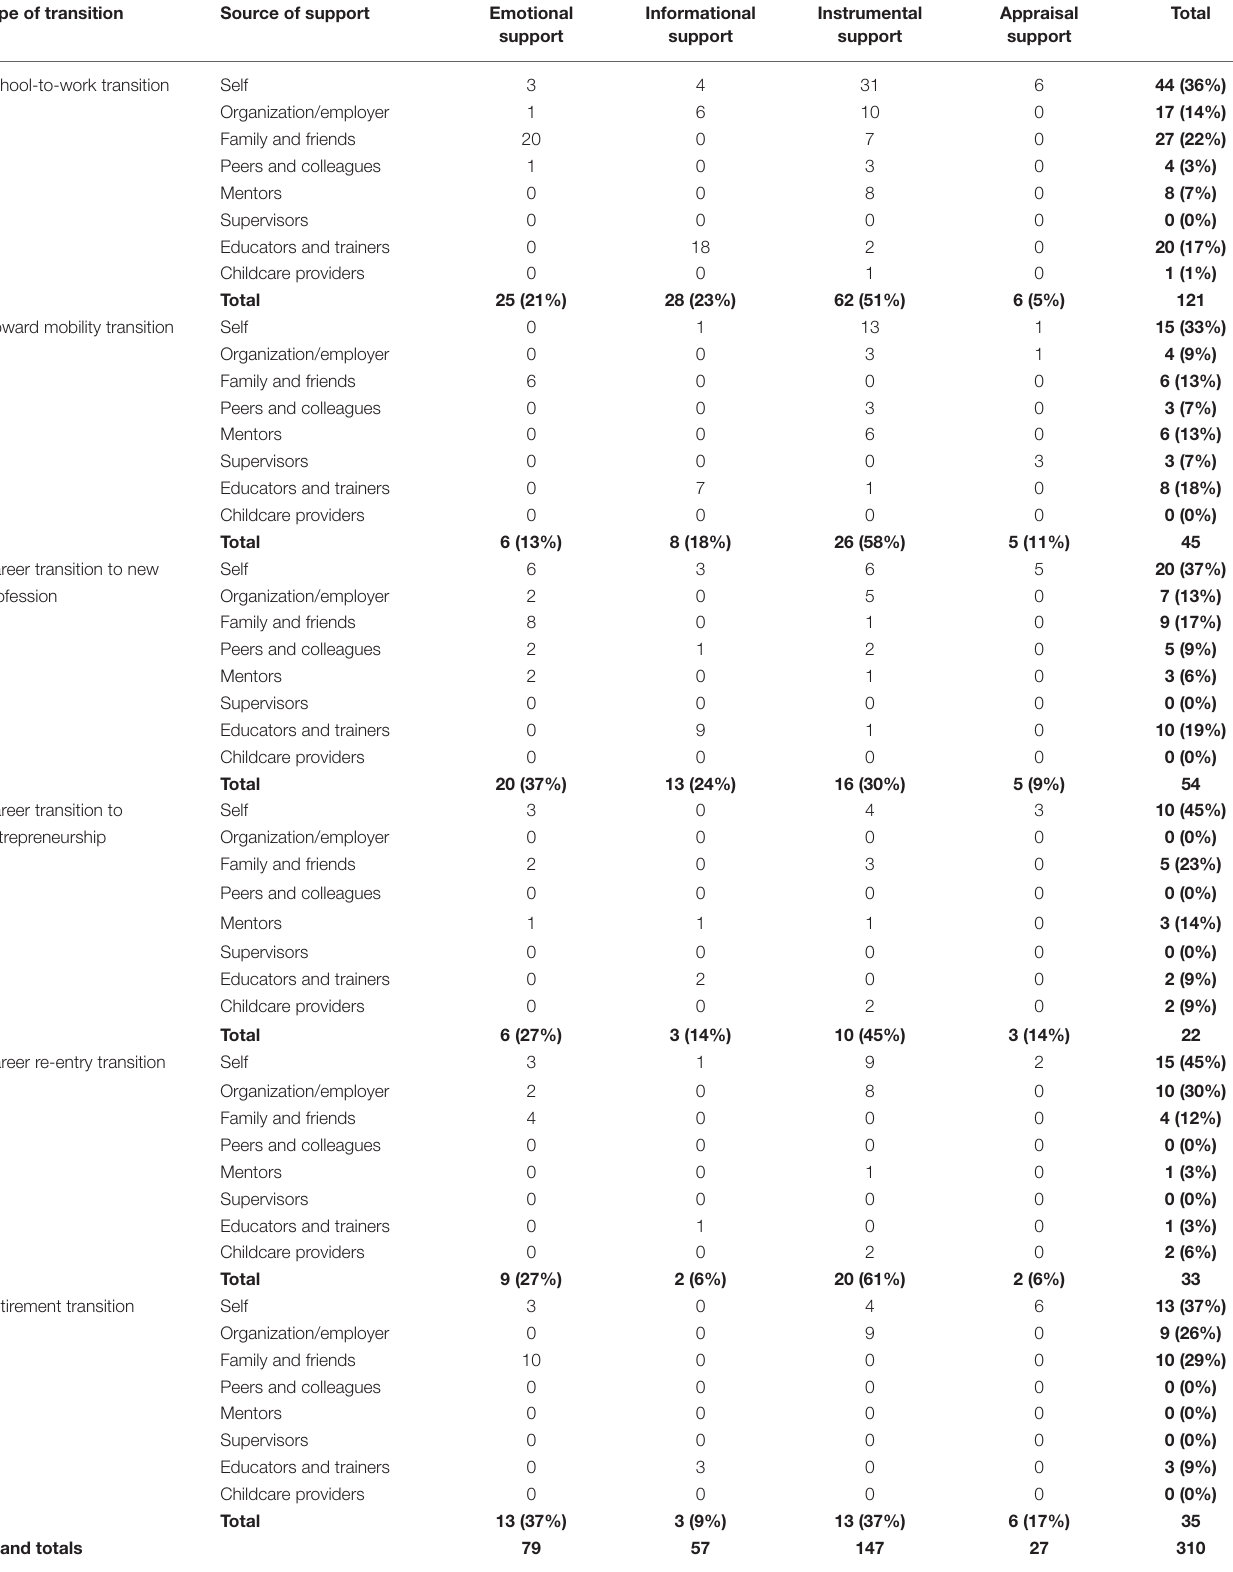
TABLE 1 | Summary of sources and types of support for all transition